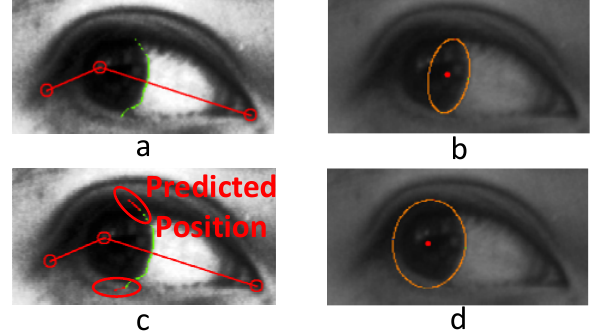
Figure 13: (a) and (b) show the edge points with Algorithm1 and are used for ellipse fitting. (c) shows the predicted edge points with Algorithm2. (d) shows the final result of ellipse fitting with detected and predicted edge points.